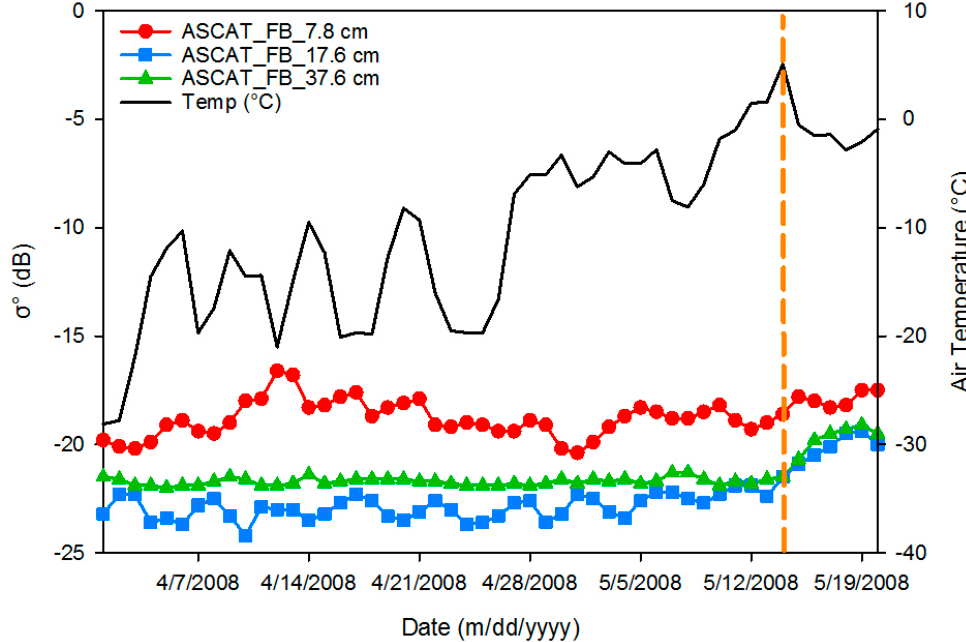
Figure 5. Time series evolution of daily mean air temperature and ASCAT σ ° for the Franklin Bay (FB) snow thickness sites between 1 April and 20 May 2008 (during the winter season). The upturn in σ ° at melt onset on ~14 May for each of the snow thickness sites is denoted by the vertical dashed line.